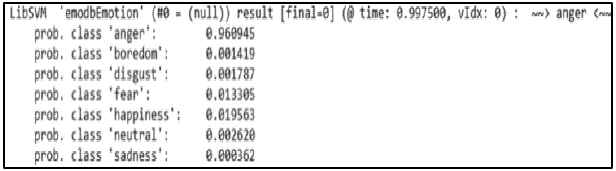
Figure 3. Histogram of boredom samples.